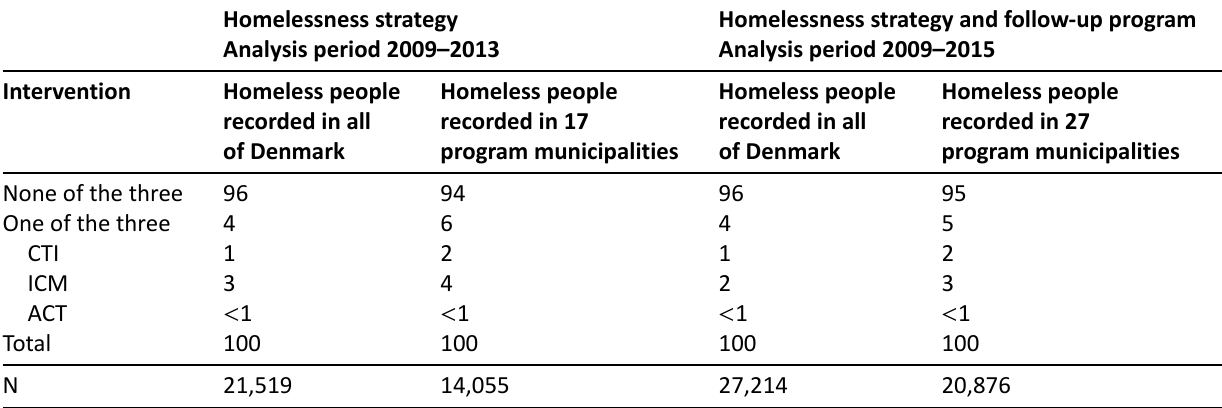
Table 1. Proportion of homeless people in Denmark receiving CTI-, ICM- or ACT-support from the Housing First program under the homelessness strategy or the follow-up program. Source: Benjaminsen and Enemark (2017, p.